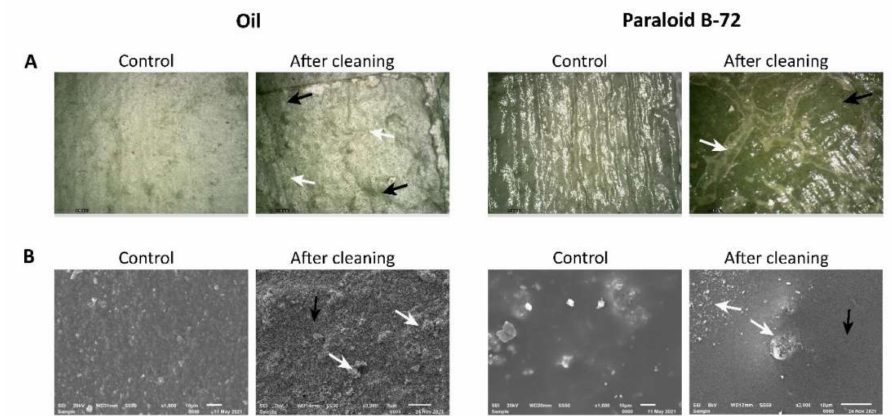
Figure 10. The efficacy of esterase-based cleaning treatments on murals (painted laboratory models) covered by sunflower oil or Paraloid B-72, evaluated by optical microscopy ( A ) and SEM ( B ). The white arrows indicate the cleaned areas, while the black arrows indicate the areas where the targeted substrates were not removed due to the uneven distribution of the enzyme on samples’